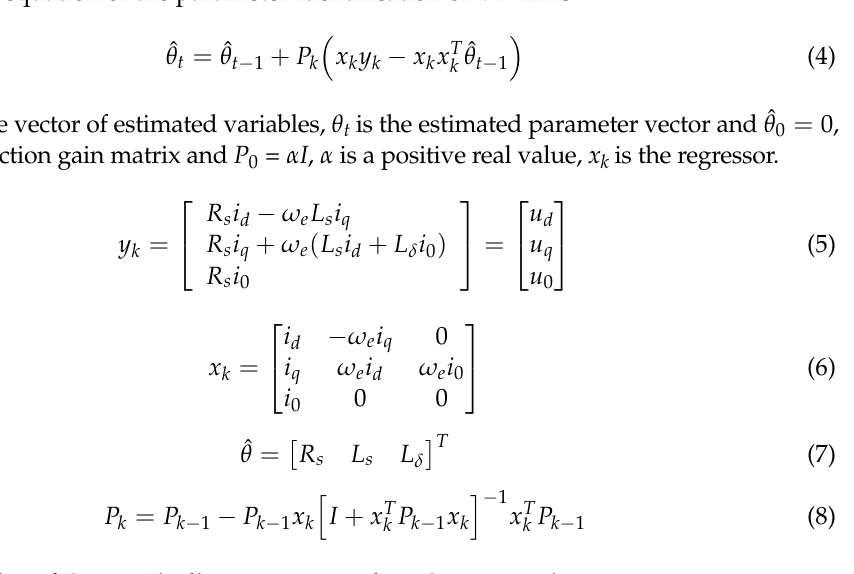
Figure 2. Topology of open winding inverter with common DC